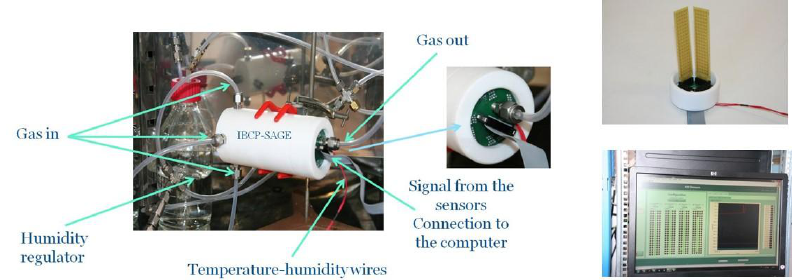
Figure 4. Exposure chamber and electronic cards.